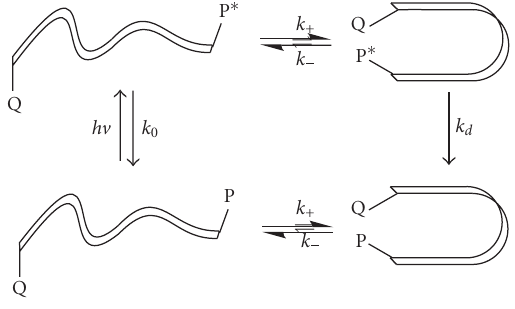
Scheme 1: Kinetic scheme for the determination of looping rates by the probe/quencher methodology.